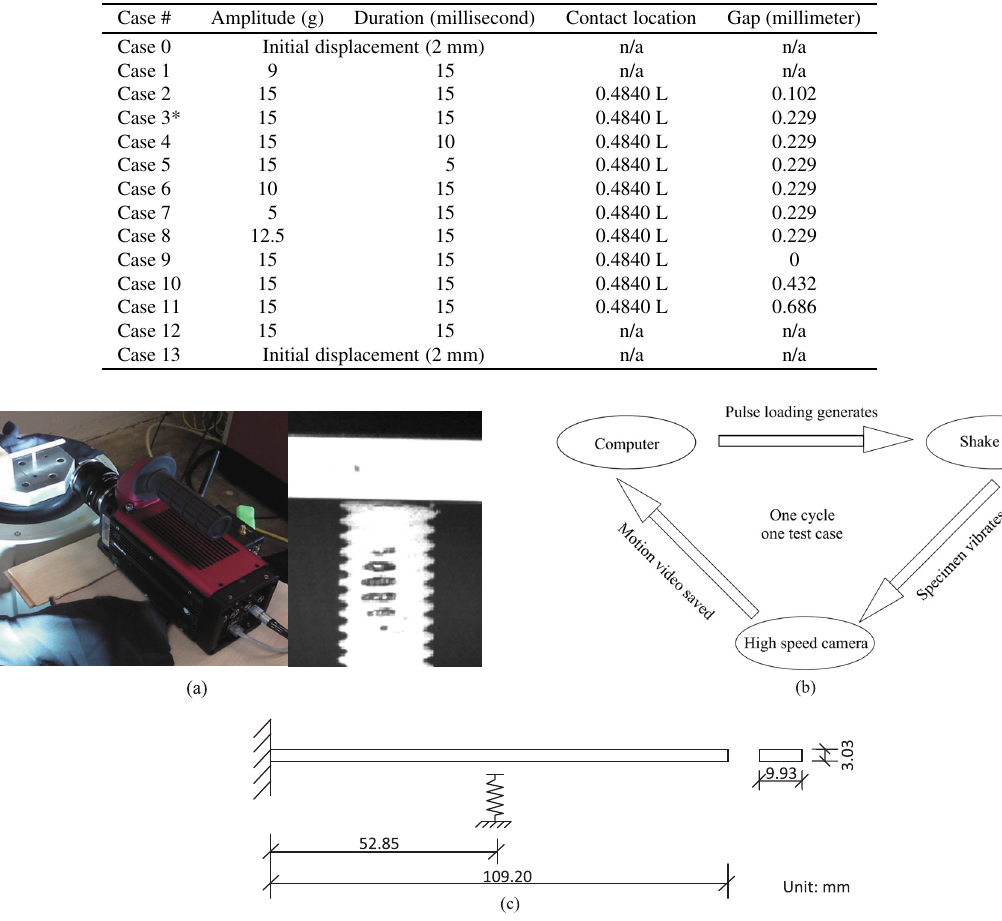
Fig. 2. (a) Complete test setup and zoom on the contactor. (b) Test procedure. (c) Schematic of the test